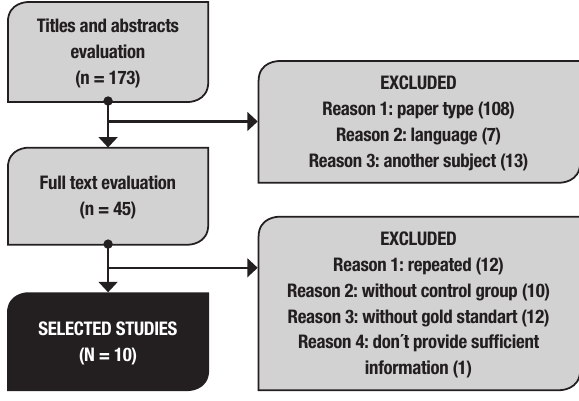
Figure 1. Study selection